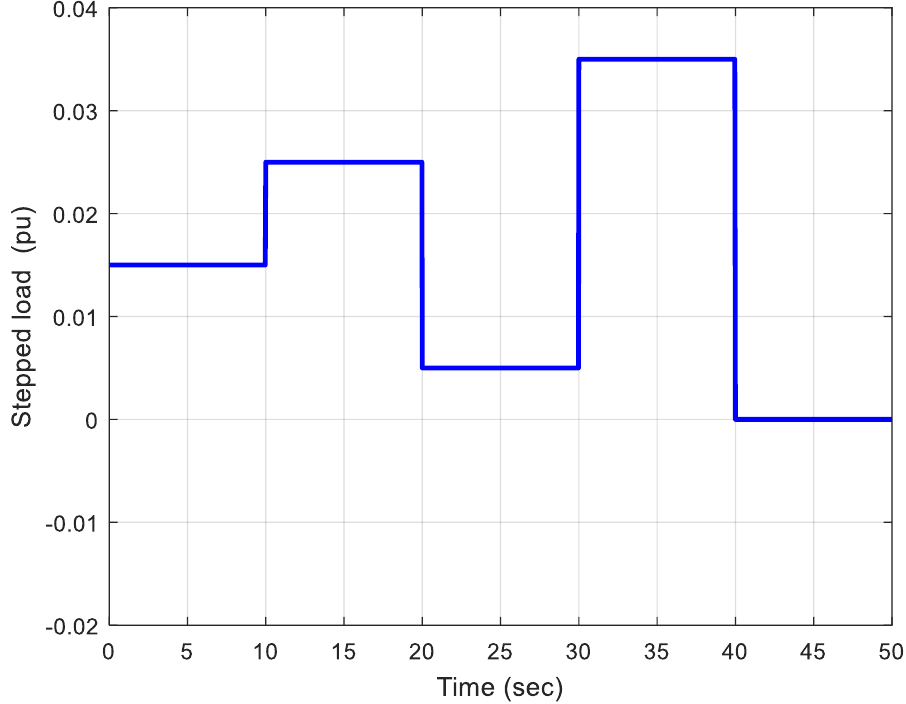
Figure 15. Stepped load changes applied to the studied system.